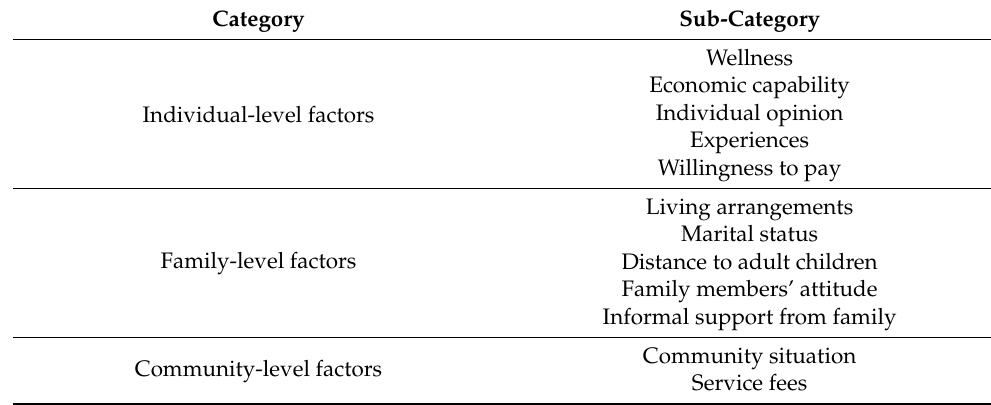
Table 4. The factors influencing the demand for CBAS integrated with medical